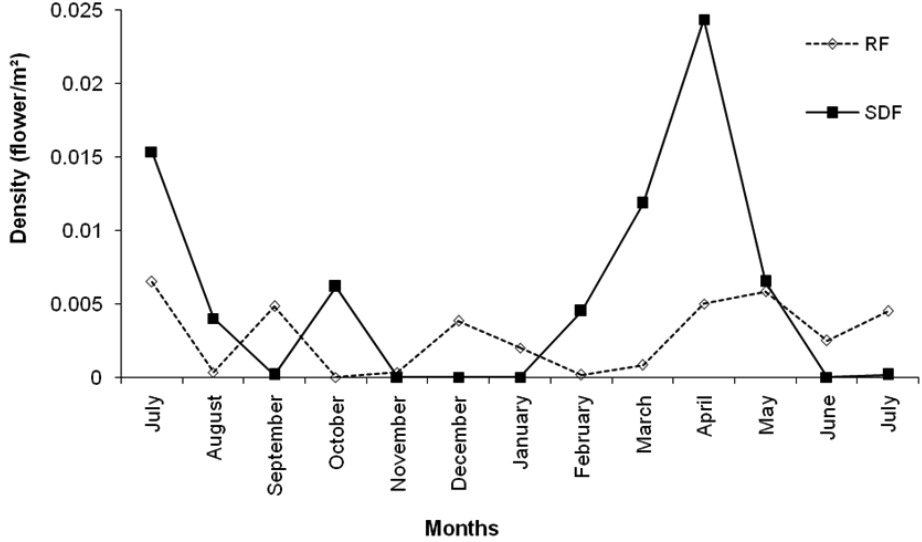
Fig. 1 – Flowering periods ( (cid:4) ) of eight ornithophilous species from two habitats in Serra da Bodoquena from June 2005 to July 2006.